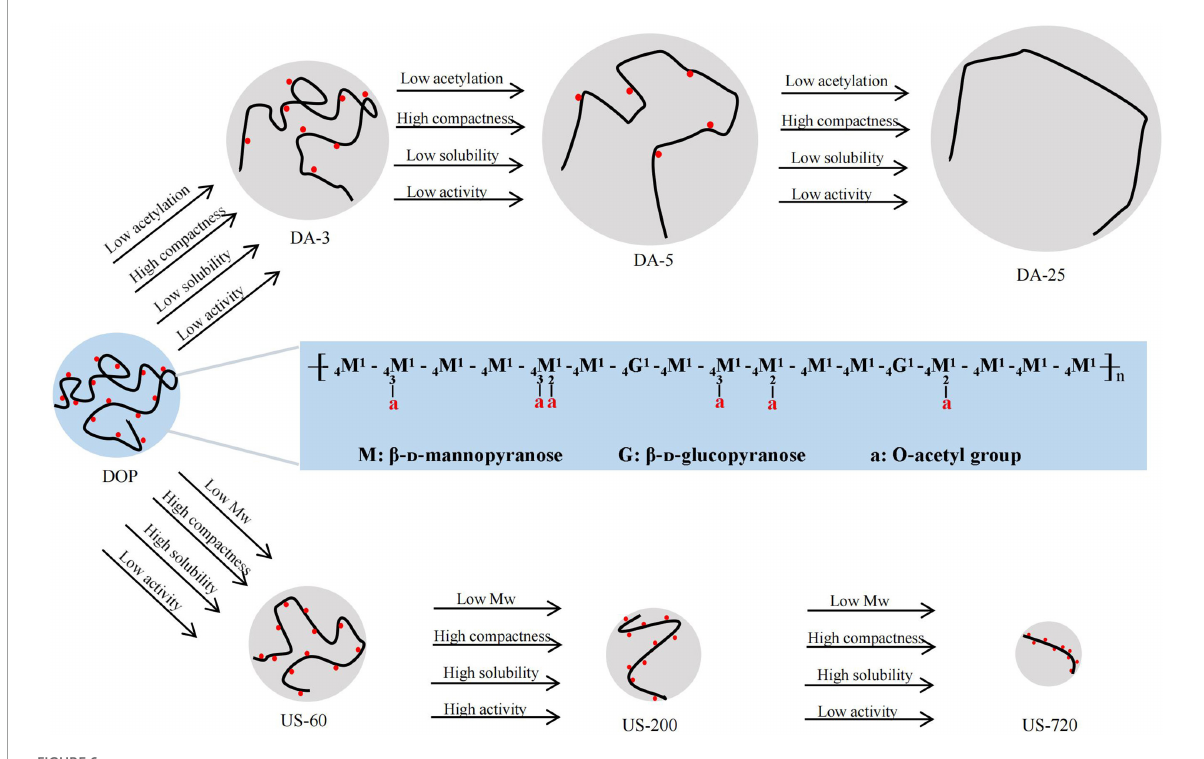
FIGURE6 Schematic diagram of structural-conformational-immunomodulatory relationships of DOP The major structure of DOP adapted from Xing et al. (7).